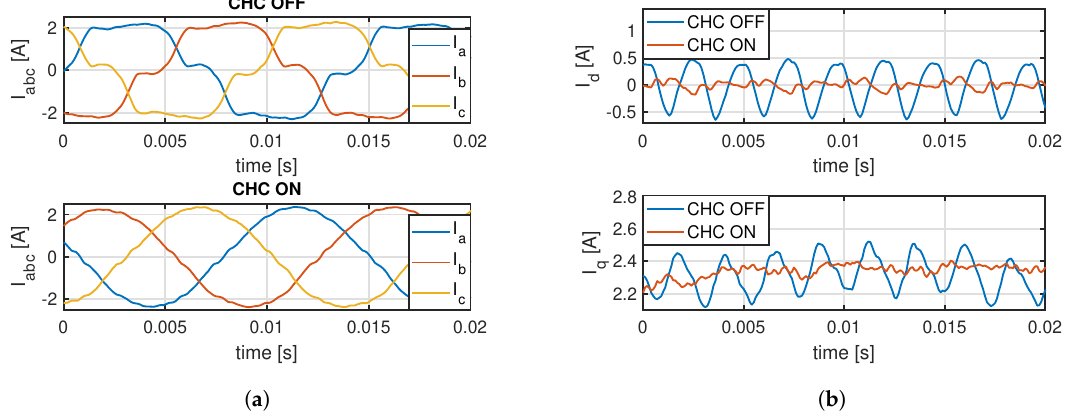
Figure 14. ( a ) abc ( b ) dq currents after application of